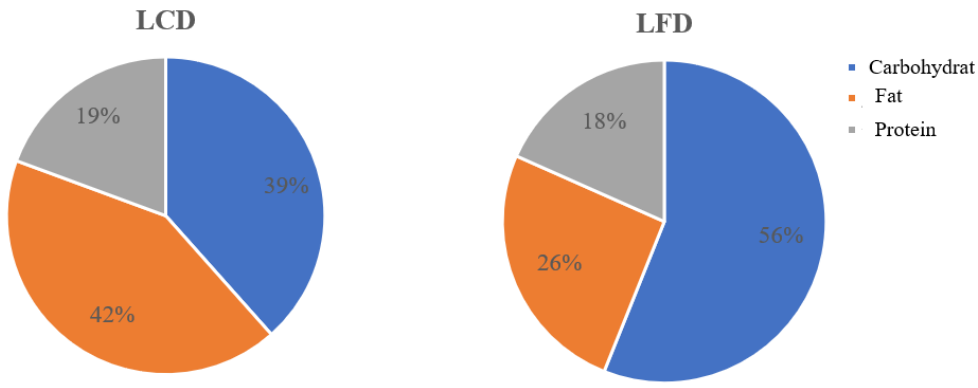
Figure 3. The percentage of the calories from carbohydrates (39%) met the standard of LCD (<45%) in the LCD group, while the 26% calories from fat met the standard of LFD. LCD: Low-carbohydrate diet; LFD: Low-fat diet